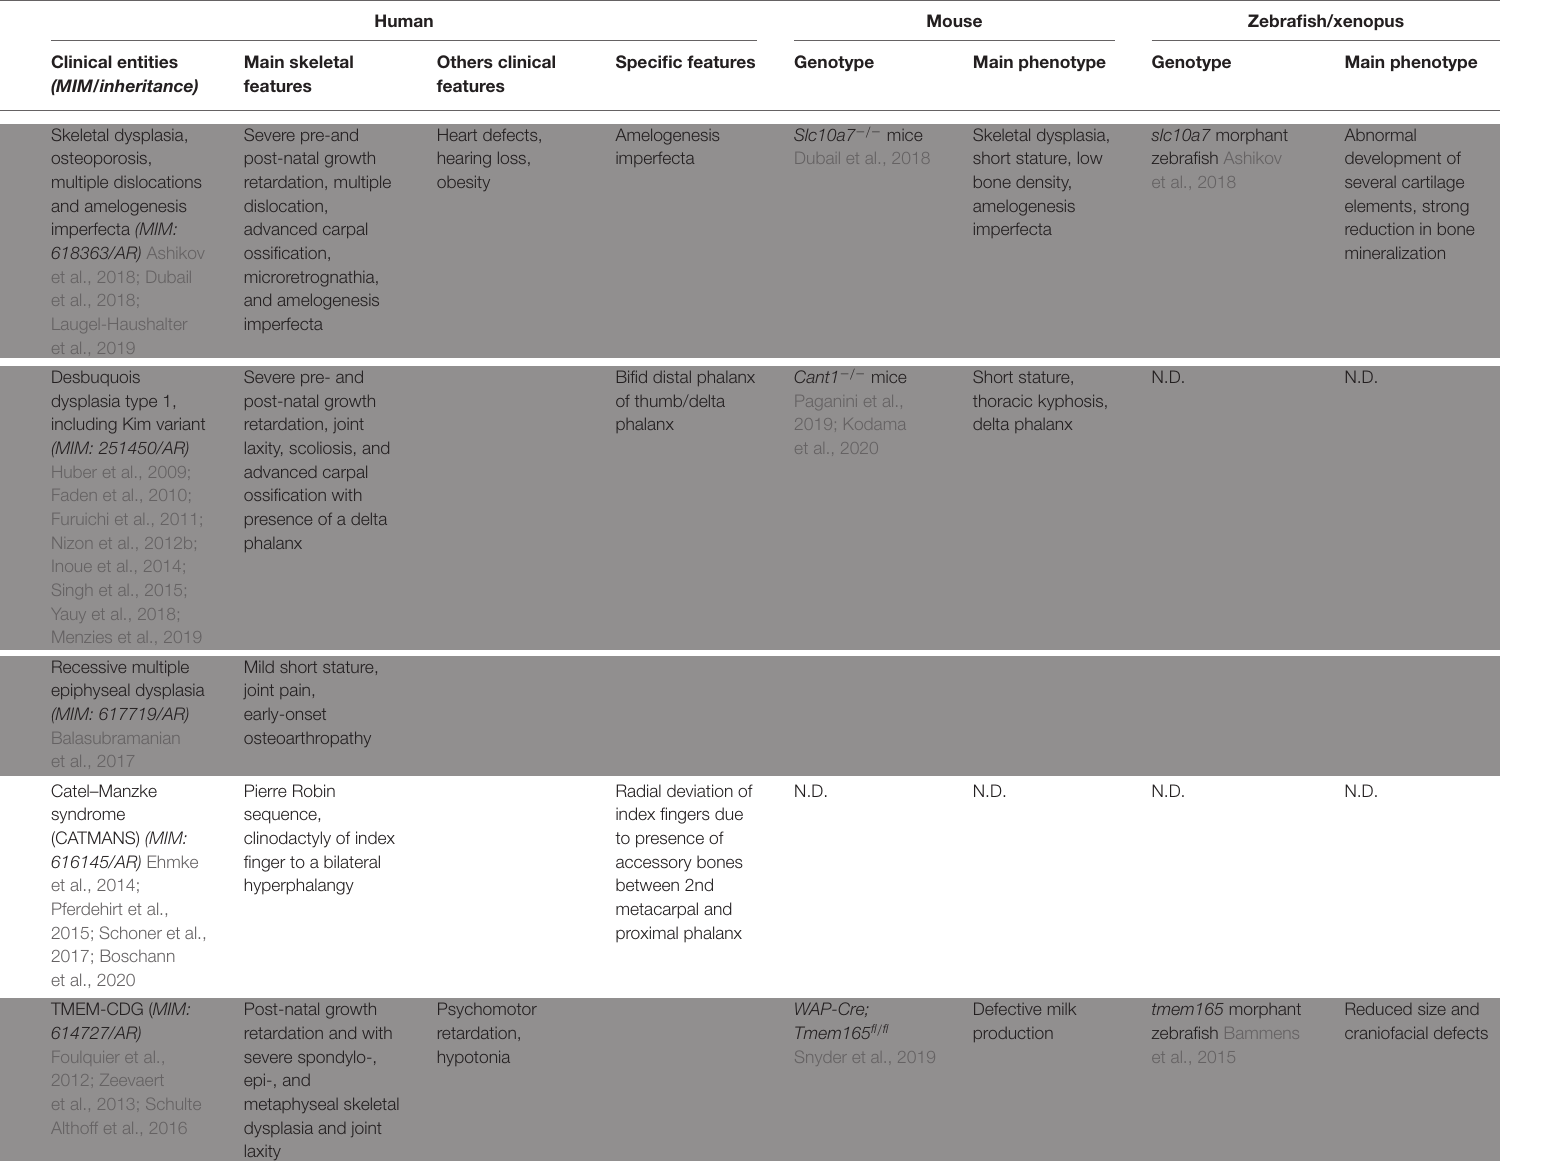
Reduced size and craniofacial defects